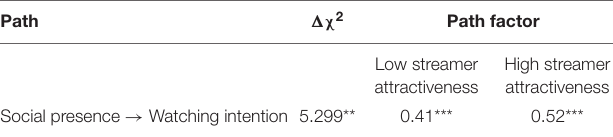
TABLE 7 | Results of multi-group analysis. Path (cid:49) χ